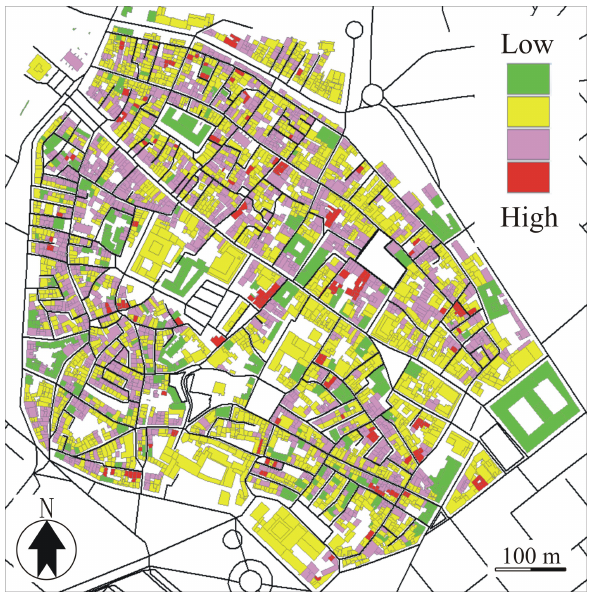
Figure 1. Map representing the state of the buildings in terms of transformation cost, from low to high.